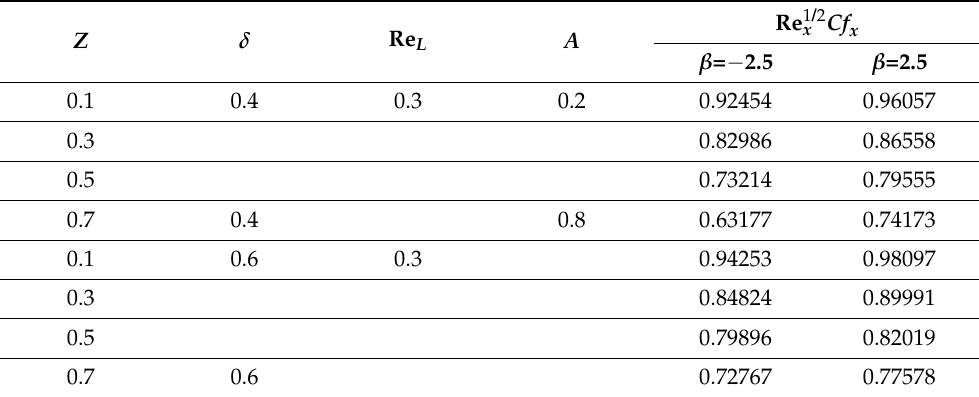
Table 3. Numerical outcomes Re 1/2 x Cf x for numerous values of Z , δ ,Re L , A